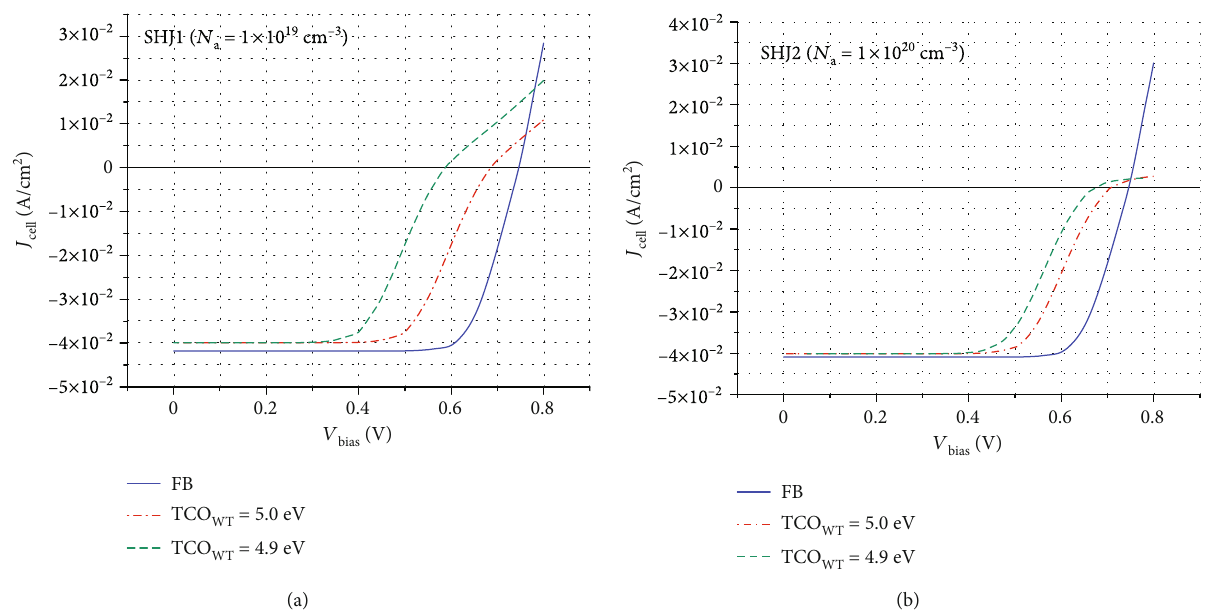
Figure 4: Simulated I-V characteristics under illumination for the two devices under study (a) SHJ1 and (b) SHJ2 with a drift-di ff usion model (thermionic emission across the heterointerface is